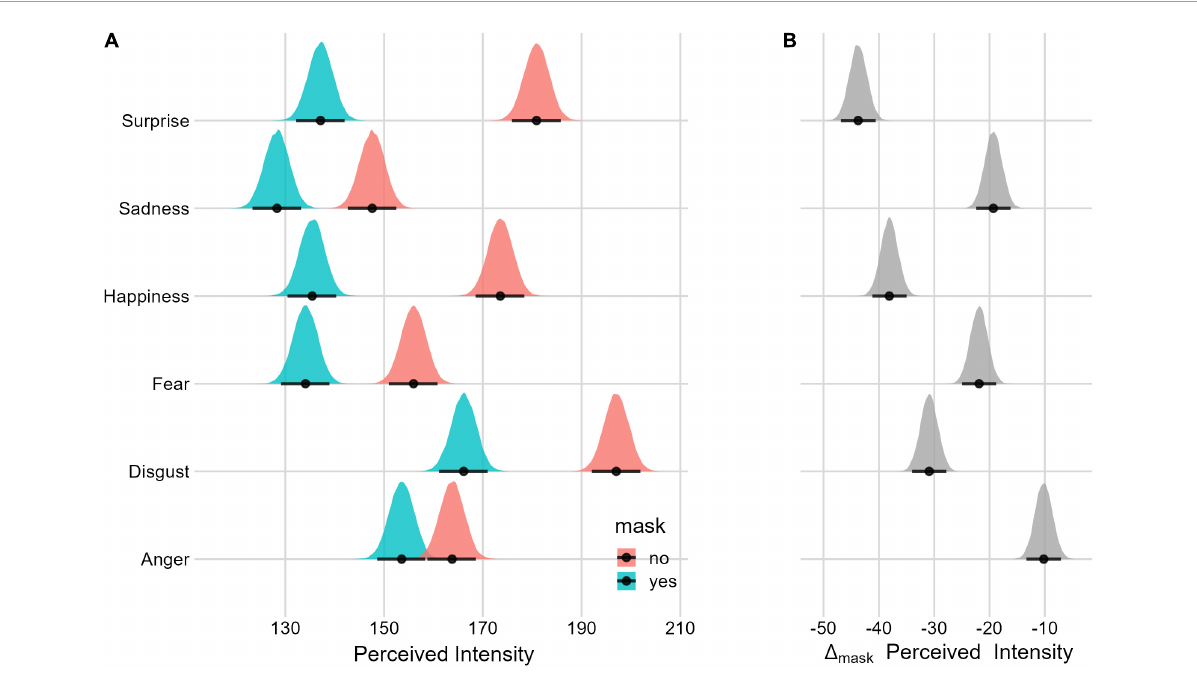
FIGURE7 Posterior distributions and 95% HPDIs of the perceived intensity Mask effect (A) Perceived intensity posterior distributions as a function of the Mask condition. (B) Posterior distribution of the Mask (cid:49) (Mask yes –Mask no ).